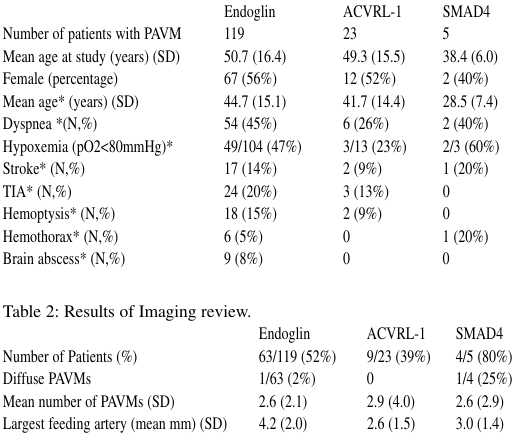
Table 1: Patient characteristics and symptoms and complications. *At initial assessment.